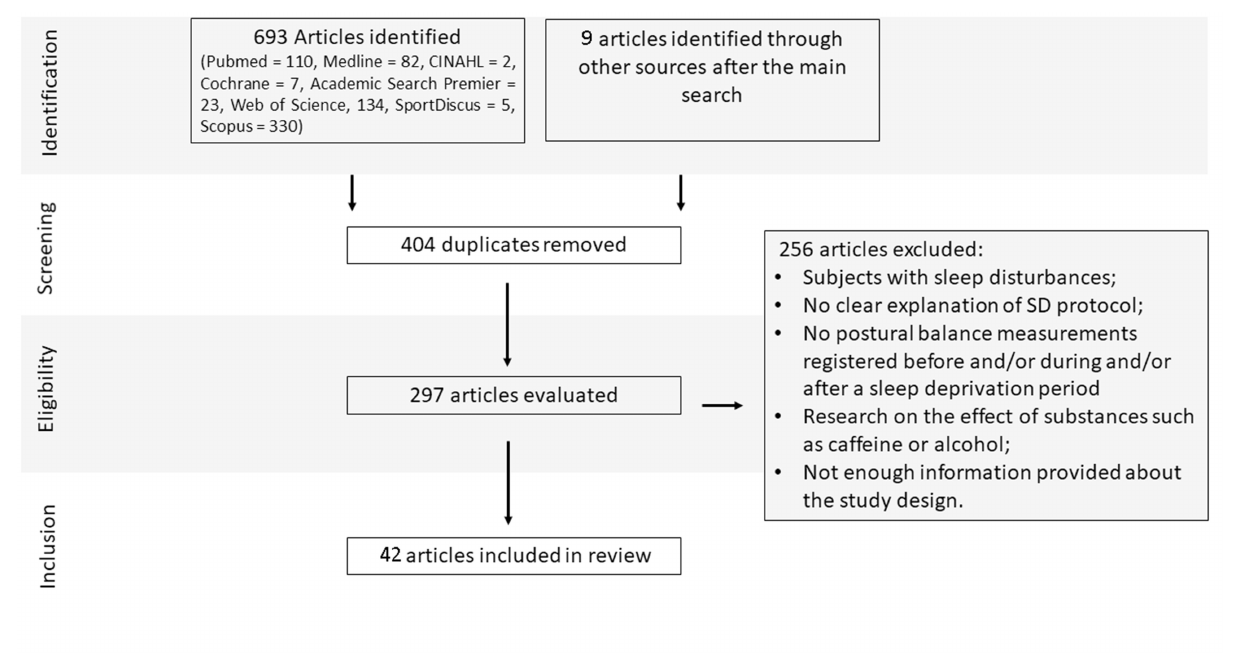
FIGURE 1 | Study flow diagram and results of the literature search.